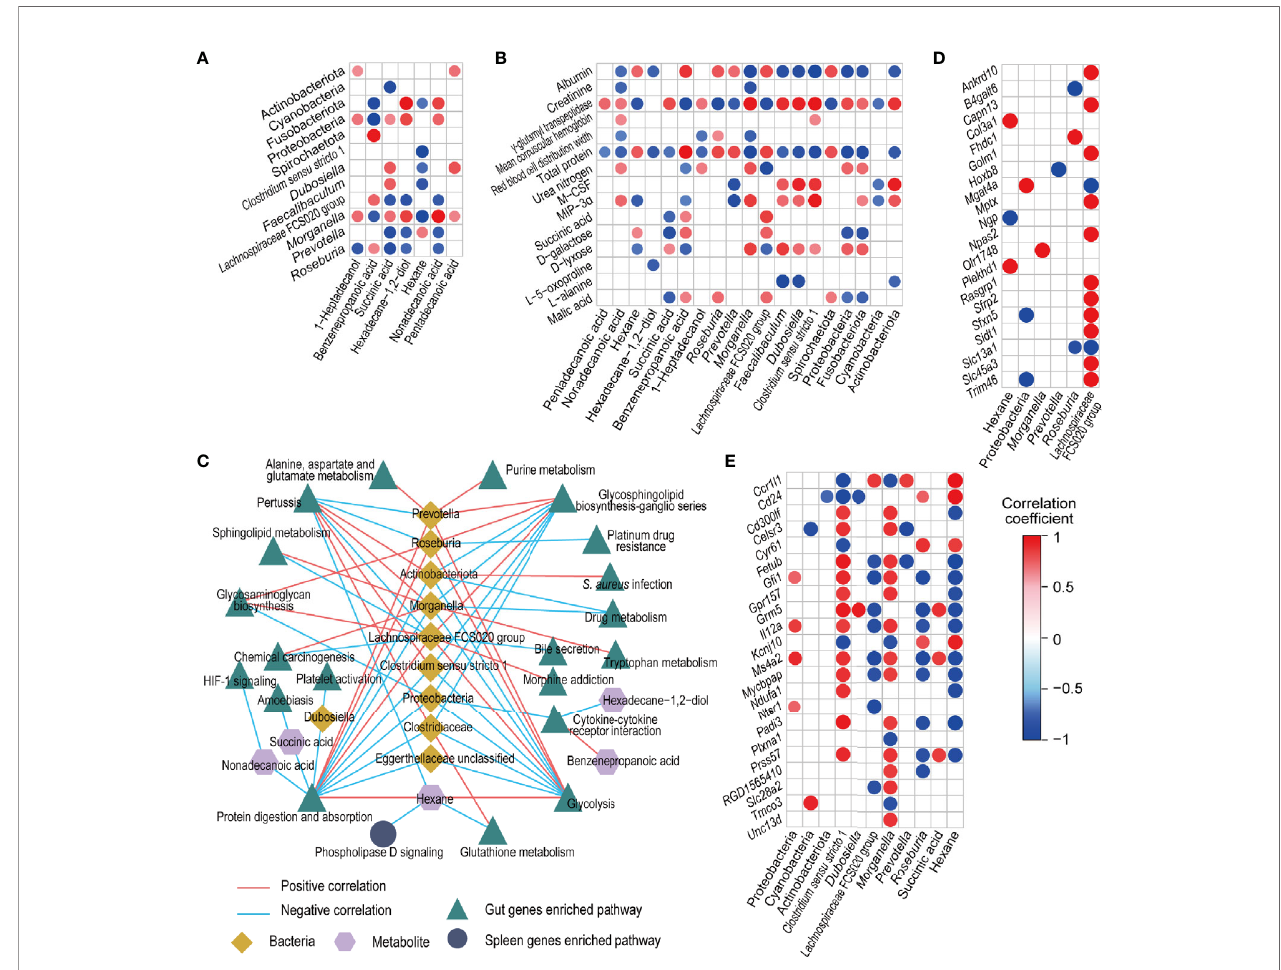
FIGURE 6 | Associations between fecal bacteria, fecal and serum metabolites, and gut and spleen genes in fl uenced by CBLEB. (A) Correlation of CBLEB-in fl uenced fecal bacteria with fecal metabolites. (B) Correlation of CBLEB-in fl uenced fecal bacteria and metabolites with blood cytokines, metabolites, and indicators of the liver and kidney functions. (C) Pathways identi fi ed based on the genes that were positively or negatively correlated with individual bacteria or metabolites according to the KEGG database analysis ( P < 0.01). The correlation coef fi cients for individual bacteria or metabolites within the corresponding pathway are presented as the mean correlation coef fi cient of all genes in the pathway positively or negatively correlated with individual bacteria or metabolites. (D) Correlation of CBLEB-in fl uenced fecal bacteria and metabolites with the gut genes ( P adj < 0.01). (E) Correlation of CBLEB-in fl uenced fecal bacteria and metabolites with the spleen genes ( P adj <